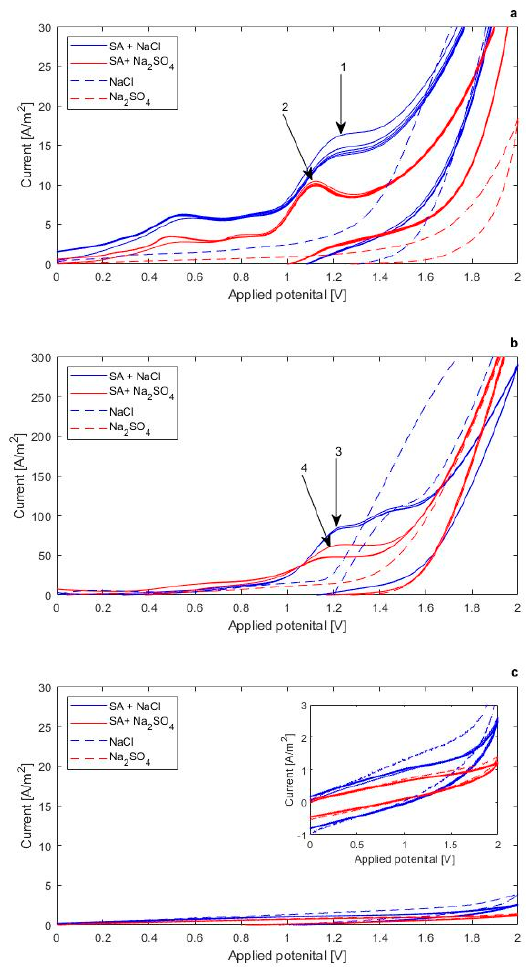
Figure 4. Cyclic voltammetry (CV) for SA in different supporting electrolytes and different anode materials (1V / s, 5 consecutive scan, current normalized for working electrode area). ( a ) GC, ( b ) Pt, ( c ) BDD.